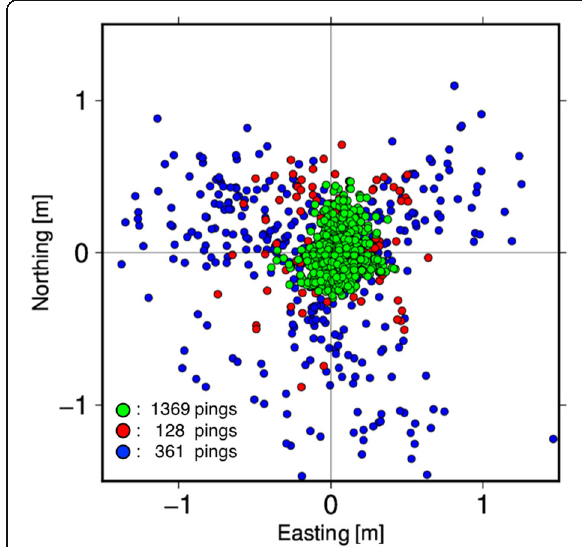
Fig. 5 Estimated array positions using ship-based campaign observation data.The blue circles indicate results obtained when observation positions are outside the array, the red circles indicate results obtained when observation positions are inside the array, and the green circles indicate results obtained from a point survey at the center of the array